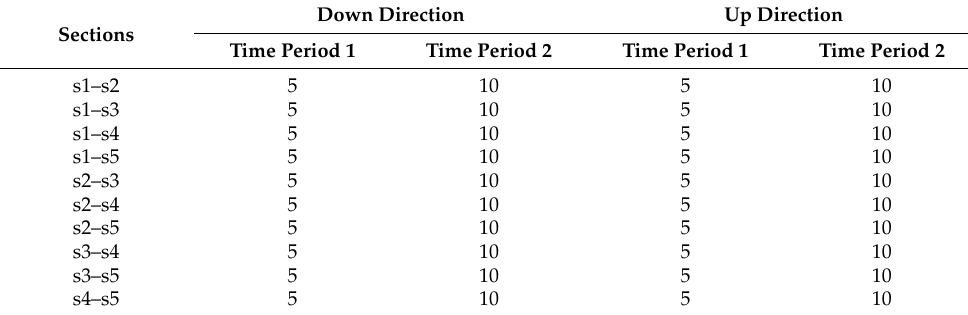
Table A2. The minimum service frequency of OD .